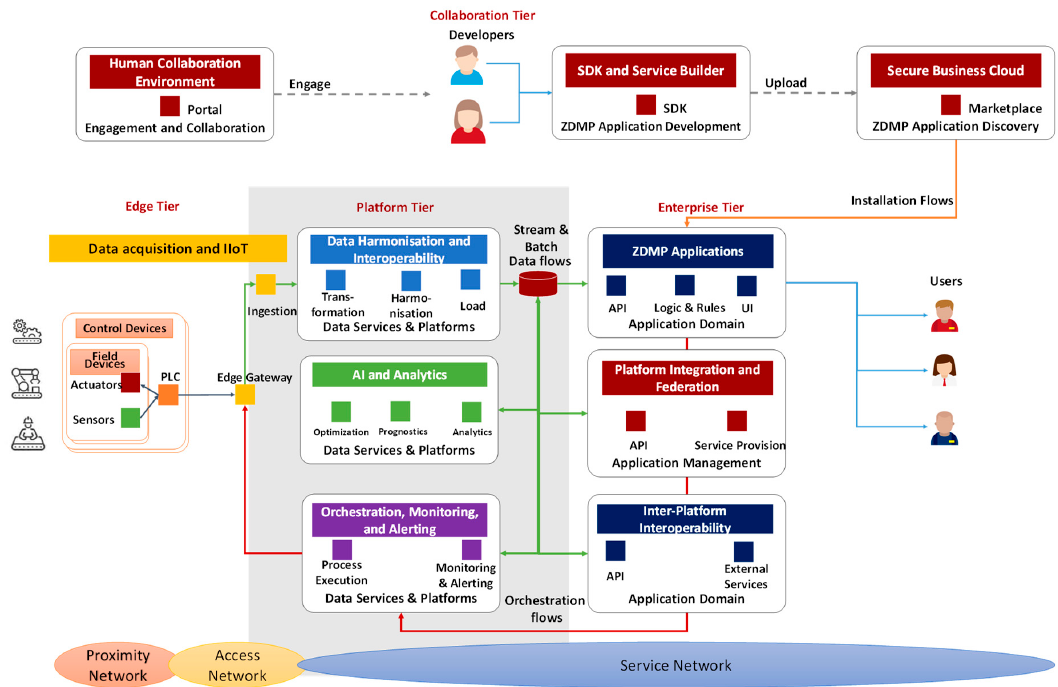
Figure 10. Mapping of Zero Defect Manufacturing Platform (ZDMP) high level architecture to the four tier architecture pattern.